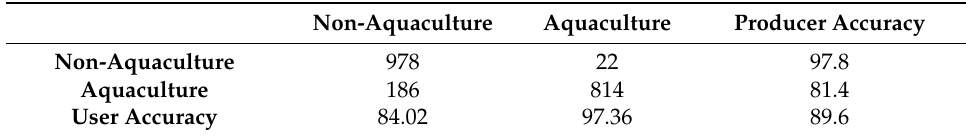
Table 1. Validation of the accuracy for the two classes obtained using the stratified random sampling method for the study area, India coast.